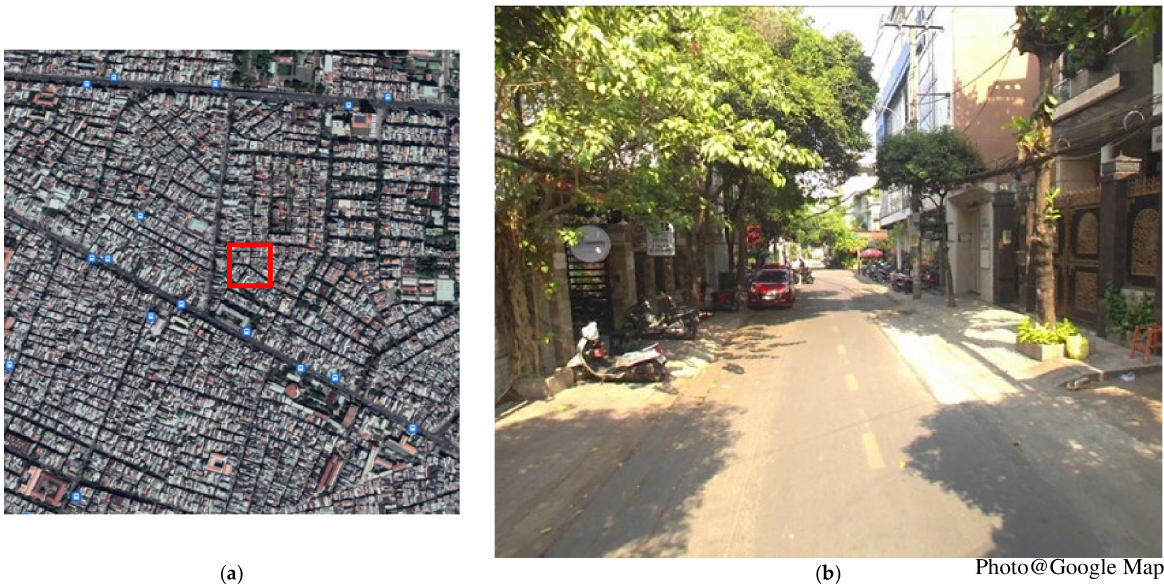
Figure 13. Differences in viewing perspectives in the same place in HCMC: ( a ) aerial view on Google Earth and ( b ) pedestrian view provided by